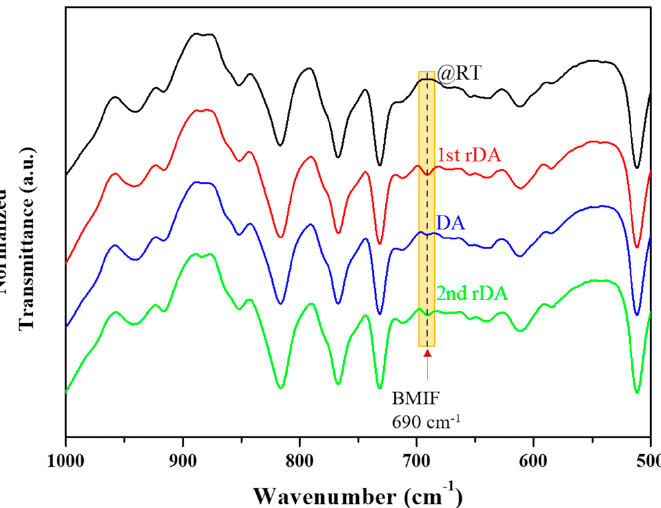
Figure 3. ATR-FTIR spectra showing the evolution of the flexible BMI (BMIF) signal at different thermal treatments for the sample PUR-B04, 25.2% TB. The band marked BMIF at 690 cm − 1 is a C=C-H deformation mode characteristic of the bismaelimide.